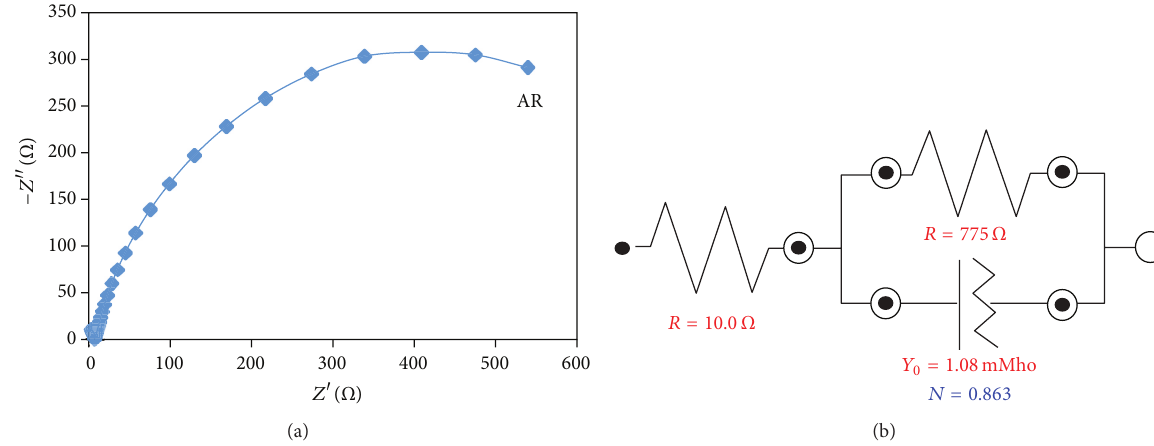
Figure 5: Determination of EIS parameters from the equivalent circuit (e.g., as received